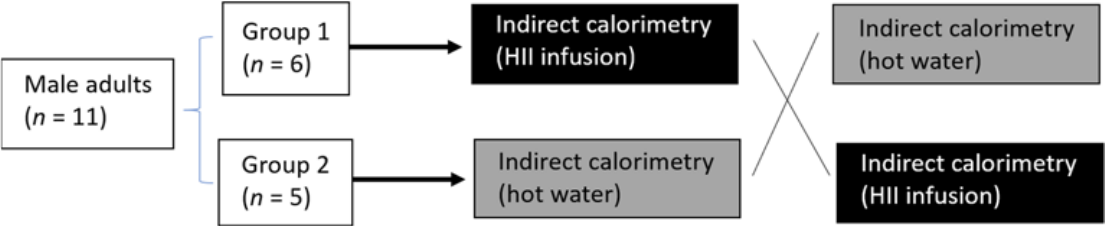
Figure 4. Study protocol for the acute pilot trial; randomized, controlled, crossover study.